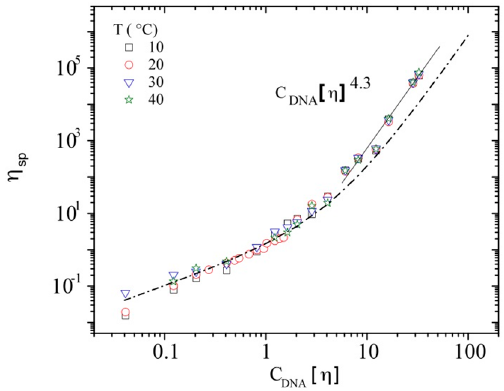
Figure 9. Specific viscosity at zero shear rate as a function of the overlap parameter C [ η ] for calf-thymus DNA solutions in TE buffer pH 7.3 at different C DNA and temperatures (The dashed line represents the master curve expressed by relation 6).